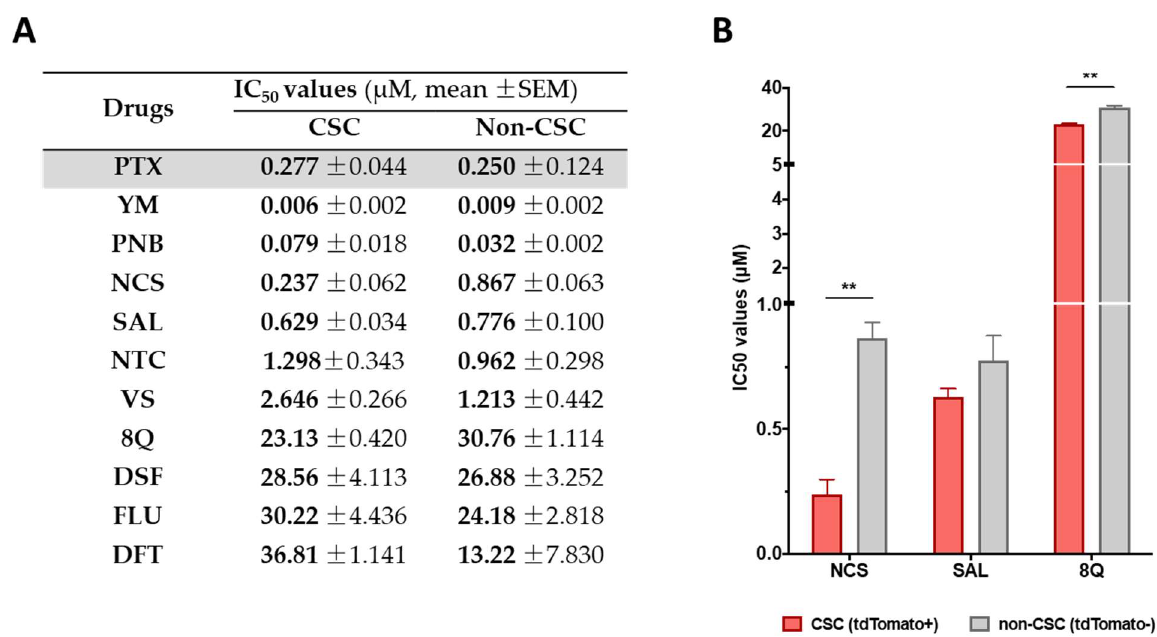
Figure 1. Selective anti-CSC activity of screened drugs in CSC and non-CSC MDA-MB-231 cells grown under attachment conditions. ( A ) IC 50 values for each compound in both subpopulations after 72 h of incubation. ( B ) Representation of IC 50 of compounds that showed a greater cytotoxic effect against CSCs compared to non-CSCs. Differences were statistically significant (** p < 0.01) when comparing IC 50 values of 8Q and NCS between both cell subpopulations, but not in the case of SAL. Data are represented as the mean ± SEM of three independent experiments.